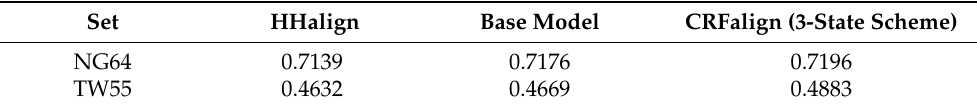
Figure 5. TM scores of structure models of NG64 set and TW55 set obtained by running Modeller on the CRFalign alignments (three-state scheme) at various train steps ( top left : steps 0, top right : step 2, bottom left : step 4 and bottom right : 9) in comparison with the results of HHalign. Table 1. Modeling accuracies in TM score of the test sets NG64 and TW55 based on training with